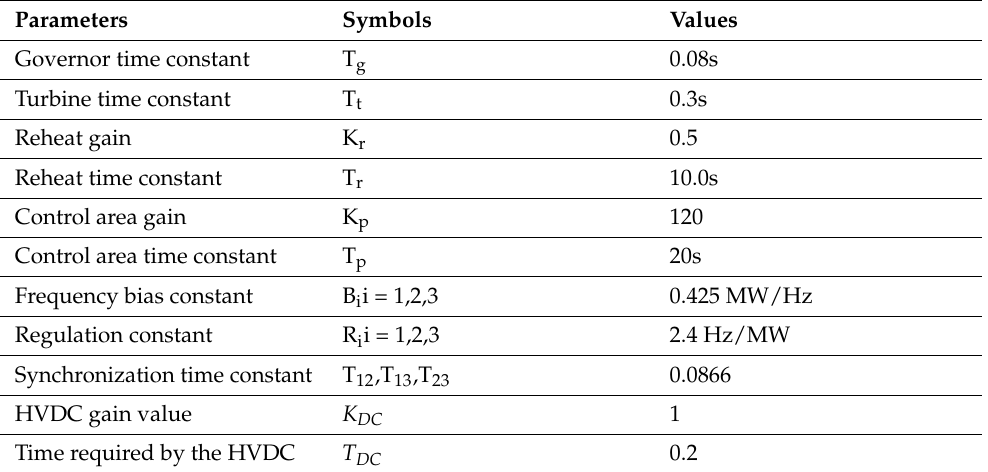
Table 1. Parameters used for simulation of the power plant model under study.